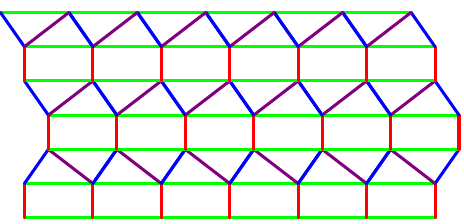
Fig. 20: Tiling with two equal non-rectangular parallelograms and with three equal isosceles triangles (NC).